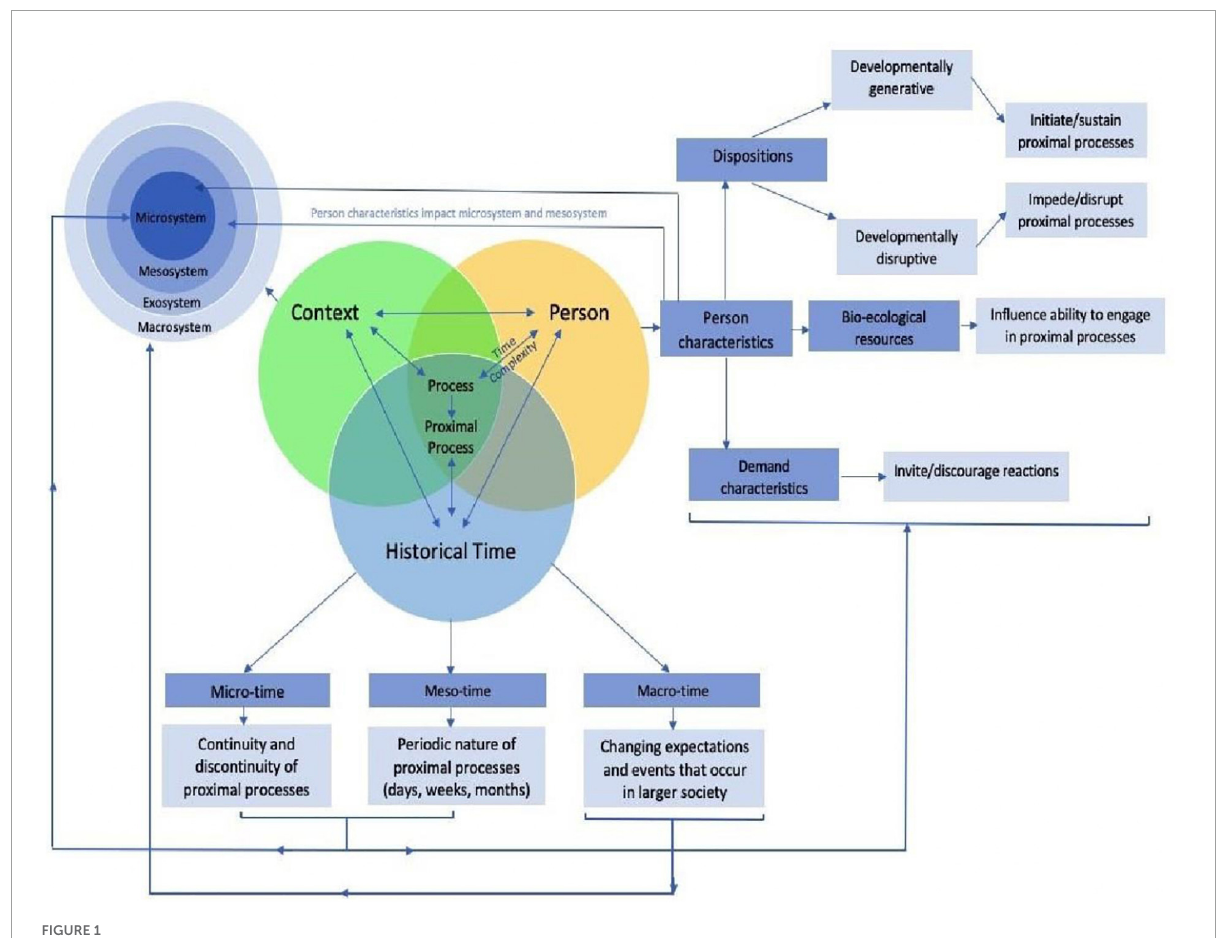
FIGURE1 Bio–ecological model